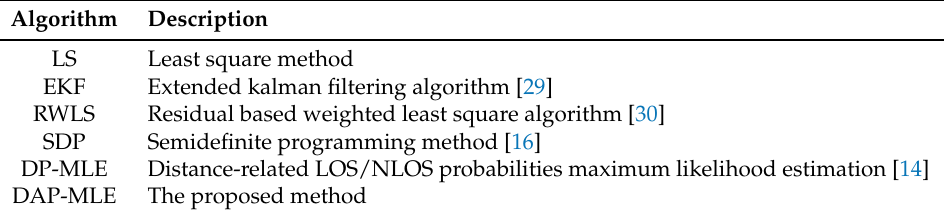
Table 1. The list of the considered algorithms and